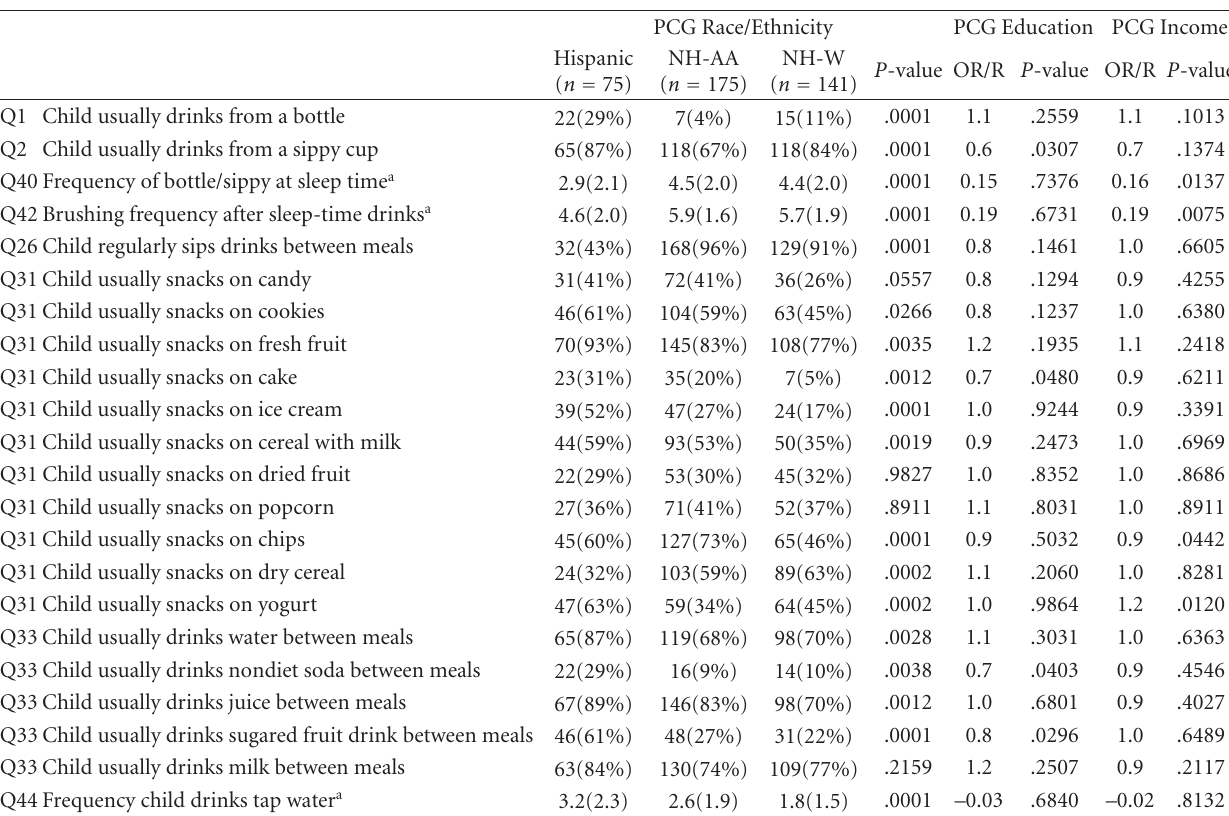
Table 3: Relationships of race/ethnicity, education, and income with questionnaire responses for snacking and drinking habits of the toddler. Analyses were performed for each questionnaire item using multivariable logistic or linear regression models with race/ethnicity, income, and education as predictors. Race/ethnicity P -values are for the overall test of any di ff erence among the three groups. Questionnaire item numbers are listed in the left-most column (see the appendix for questionnaire). N (%) or Mean(SD) for race/ethnicity, odds ratio (OR) or correlation (R) for education and income. NH-AA = Non-Hispanic African-American, NH-W = Non-Hispanic